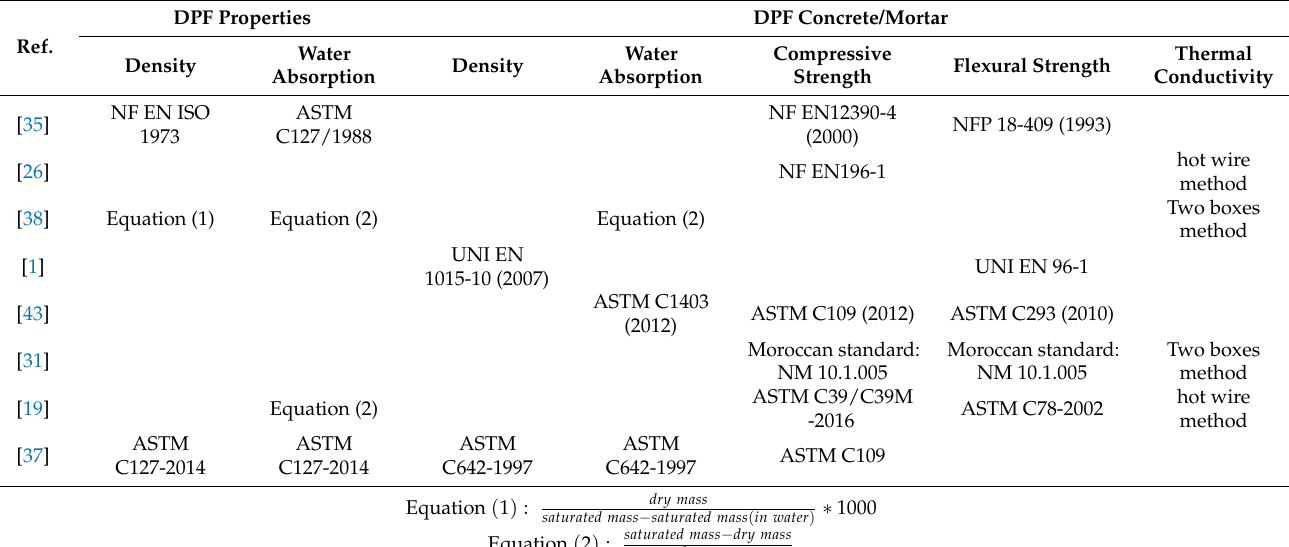
Table 4. Summary of standard codes and methods used for testing DPF concrete/mortar.